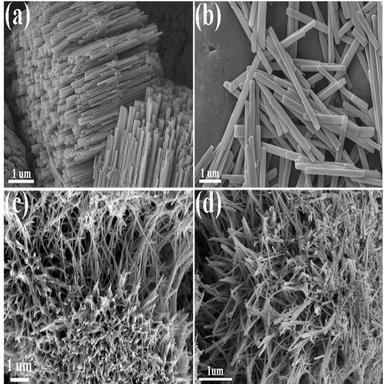
SEM images of (a) the WO3 nanorod bundles, (b) the MoO3 nanobelts, (c,d) the W0.4Mo0.6O3 nanoneedle arrays.